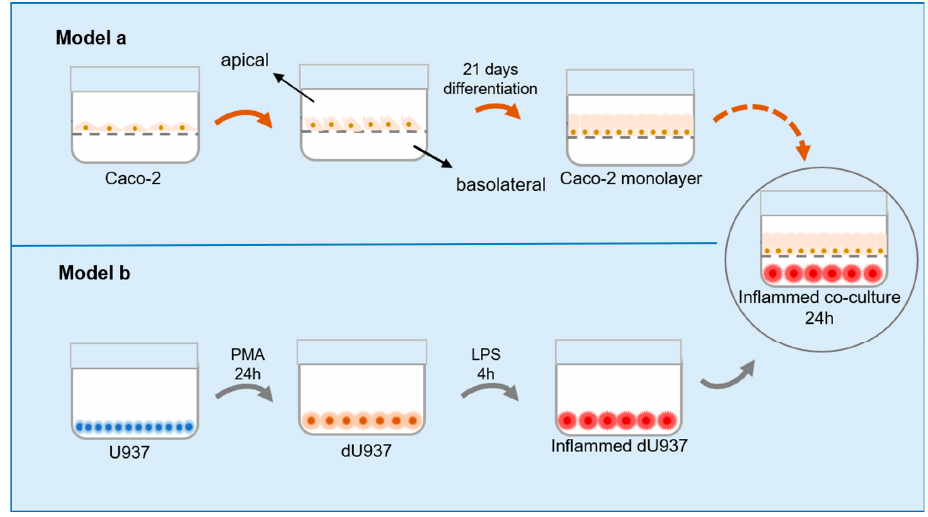
Figure 6. Schematic representation of intestinal barrier and intestinal inflammation models used. Model a . For the establishment of an in vitro epithelial barrier model, Caco-2 cells (0.1 × 10 6 cells/well) were seeded into the apical chamber of 24-well transwell inserts, 3.0 µm pore size, (Corning, New York, NY, USA). The cells were grown and differentiated over 21 days. The CM (500 µL in the apical chamber and 500 µL in the basolateral cham- ber) was refreshed every other day for the first two weeks and then every day until the cells were fully differentiated (week